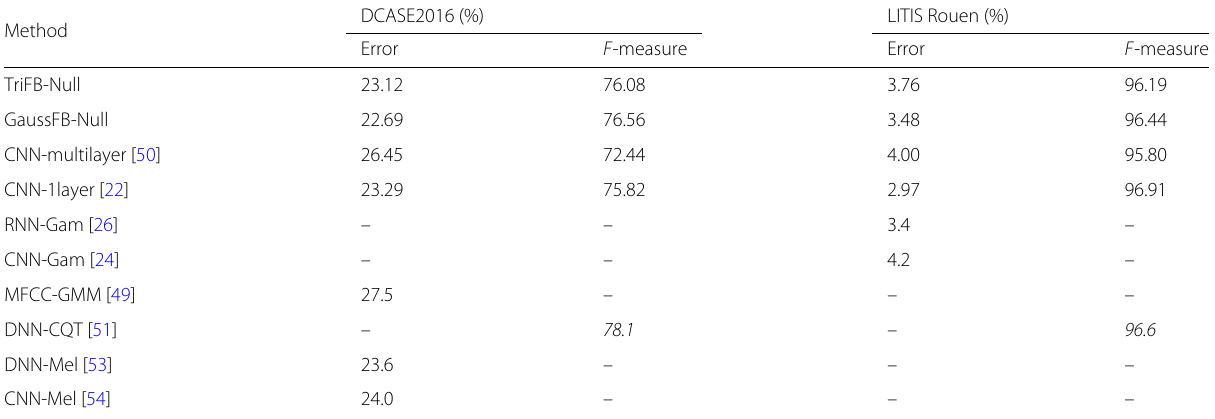
Table 3 Average performance comparison with related works on LITIS Rouen dataset and DCASE2016 dataset